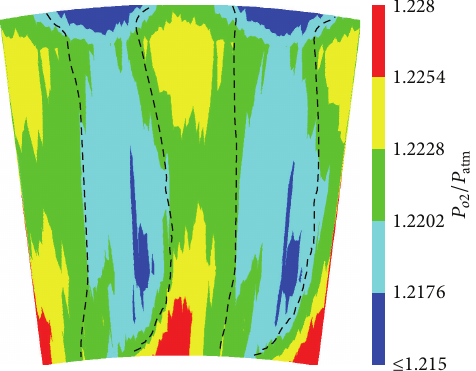
Figure 4: Time-averaged total pressure at the Rotor 2 exit plane.